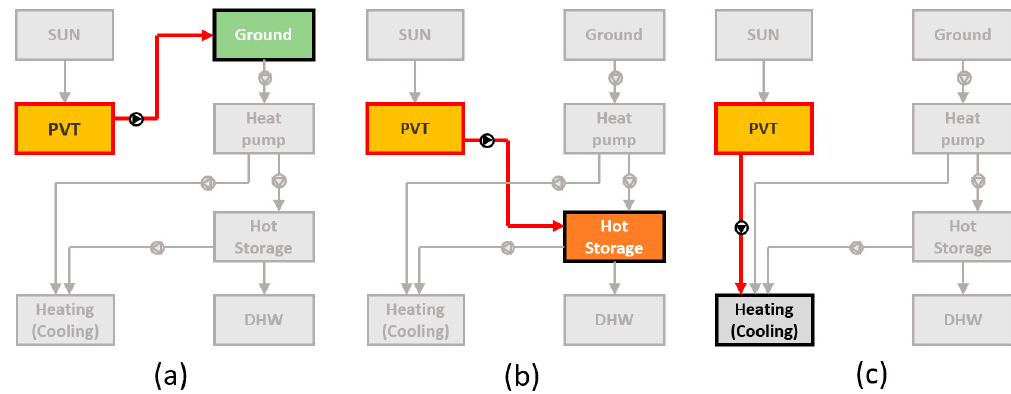
Figure 34. Conceptional designs considering connection method of PVT module. ( a ) Heat production to underground heat storage; ( b ) to hot water; ( c ) to space